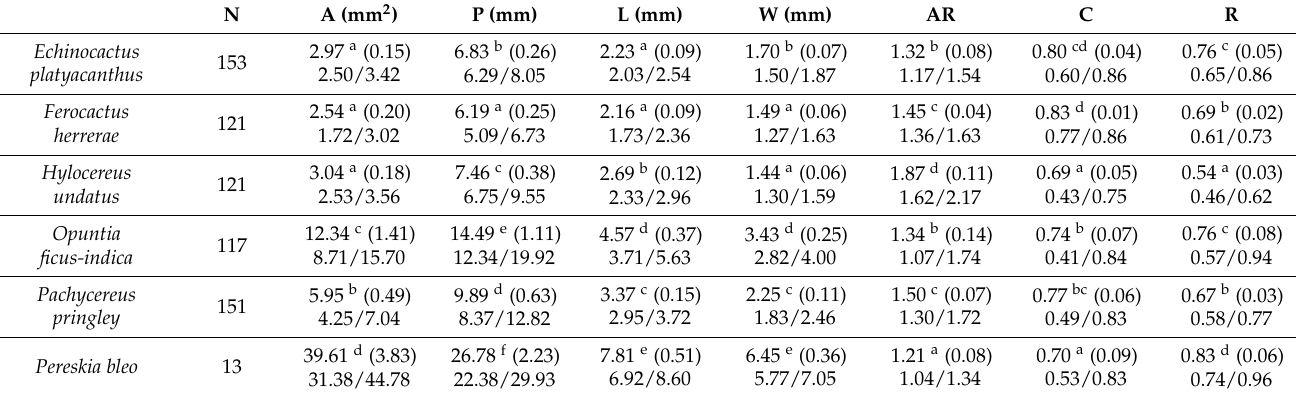
Table 1. Area (A), perimeter (P), length (L), width (W), aspect ratio (AR is L/W), circularity (C), and roundness (R) in seed samples of six species belonging to different subfamilies of the Cactaceae. A is given in mm 2 , P, L, and W in mm. The mean values marked with the same superscript letter in each column do not differ significantly at p < 0.05 (Scheff é ’s test). Standard deviation values are given in parentheses. The second row of each cell shows minimum/maximum values for each data entry. N indicates the number of seeds analyzed.